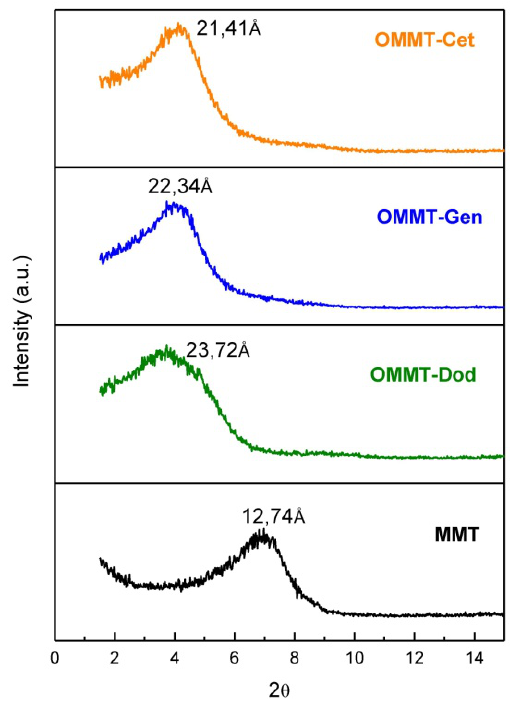
Figure 1. X-ray diffraction (XRD) patterns of the clay without treatment (MMT) and clay treated with the Dodigen (OMMT-Dod), Genamin (OMMT-Gen) and Cetremide (OMMT-Cet)